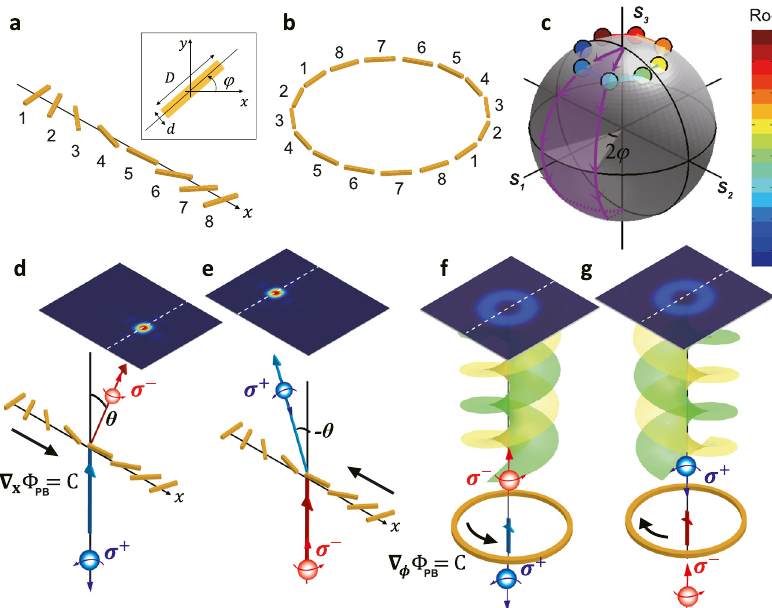
Figure 1: Array of nano-rods with a constant gradient PB phase andPoincaré sphere plot of Stokes parameters. Inset figure shows a schematic of nano-rod with length D and width d making an angle ϕ with x